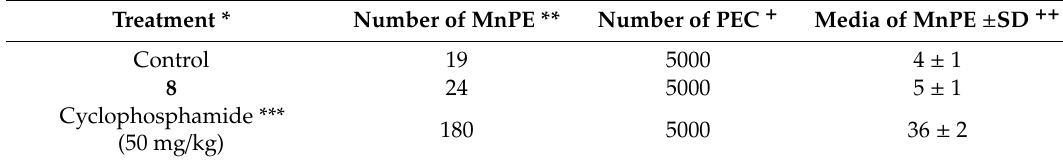
Table 3. Micronucleus test using 150 mg / Kg of compound 8 in